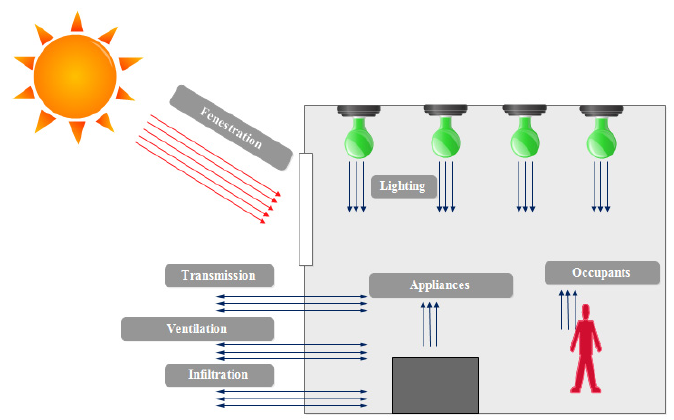
Figure 2. Energy balance of house.